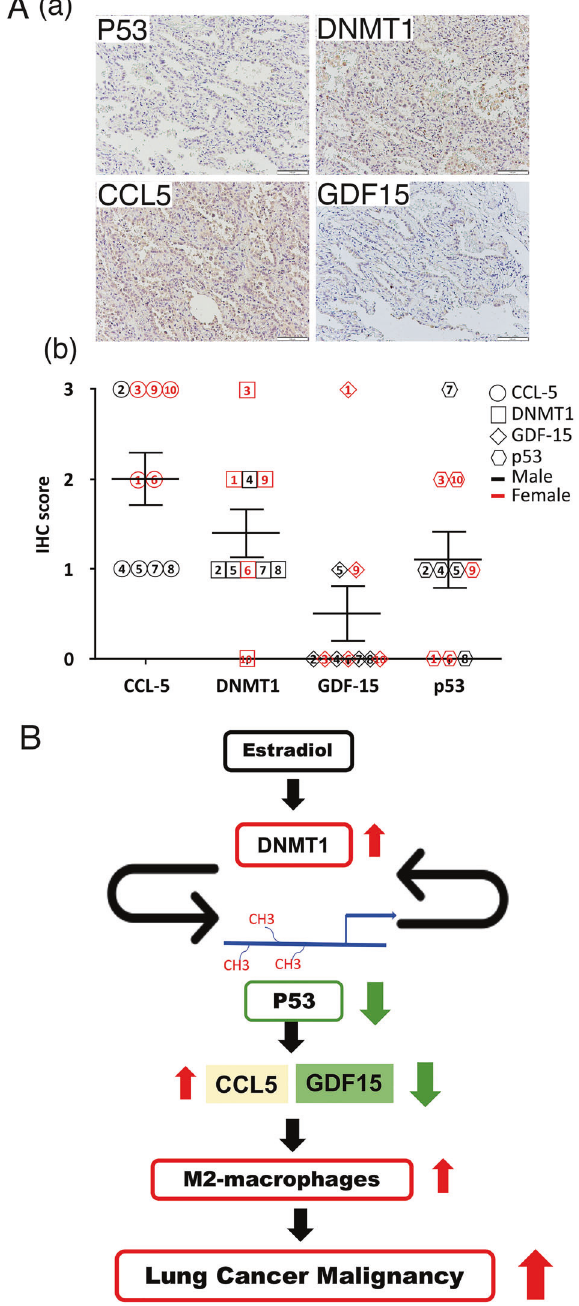
Fig. 8 Clinical relevance of the levels of p53, DNMT1, GDF15, and CCL5 in lung cancer cohorts. The ten clinical specimens were collected from early-stage lung cancer patients used to study the association among the levels of p53, DNMT1, GDF15, and CCL5 by IHC staining ( A , a ), and the results were scored from 0 to 3 according to the IHC signal ( A , b ). The working model of the role of estradiol in lung cancer malignancy is shown ( B